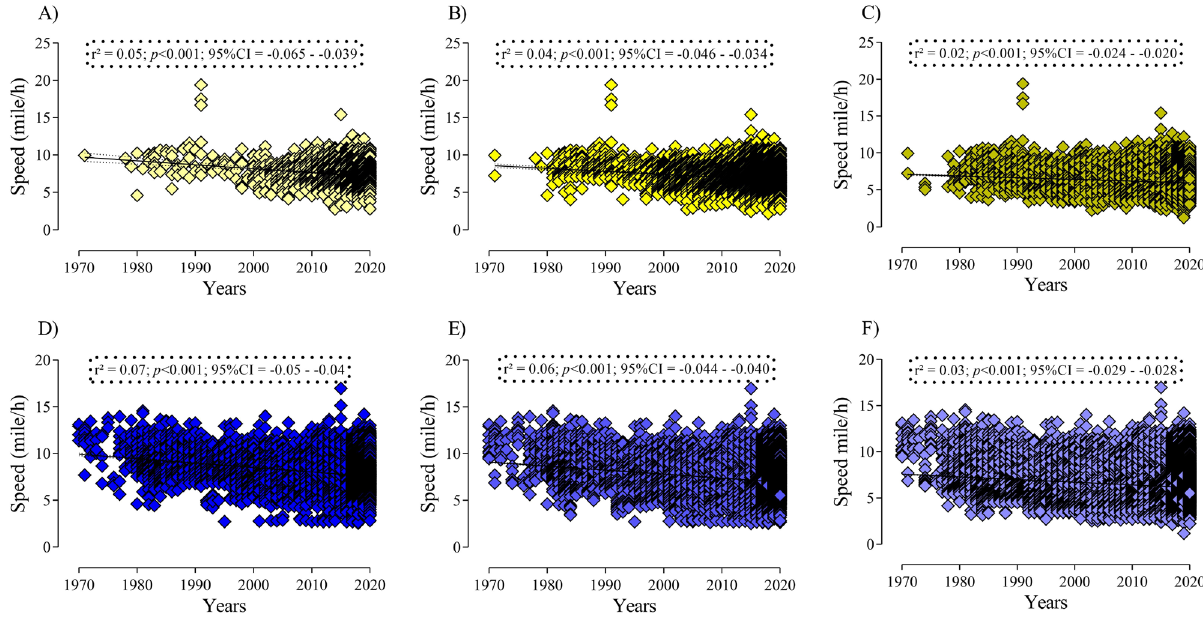
Figure 2. Linear regression results, considering all sample ( A ) Women top three; ( B ) Women top 10; ( C ) Women top 100; ( D ) Men top three; ( E ) Men top 10; ( F ) Men Top 100).